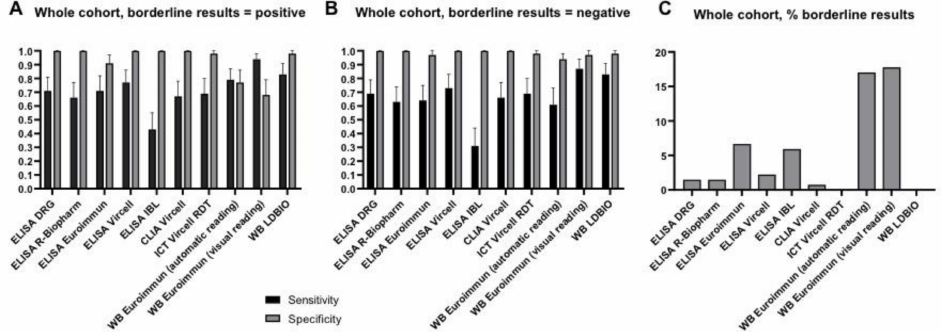
Figure 2. Diagnostic performance of the single index tests, on the whole sera cohort. Sensitivity and specificity of assays when borderline results were considered as positive ( A ) and negative ( B ). Percentage of borderline results ( C ). Error bars represent 95%